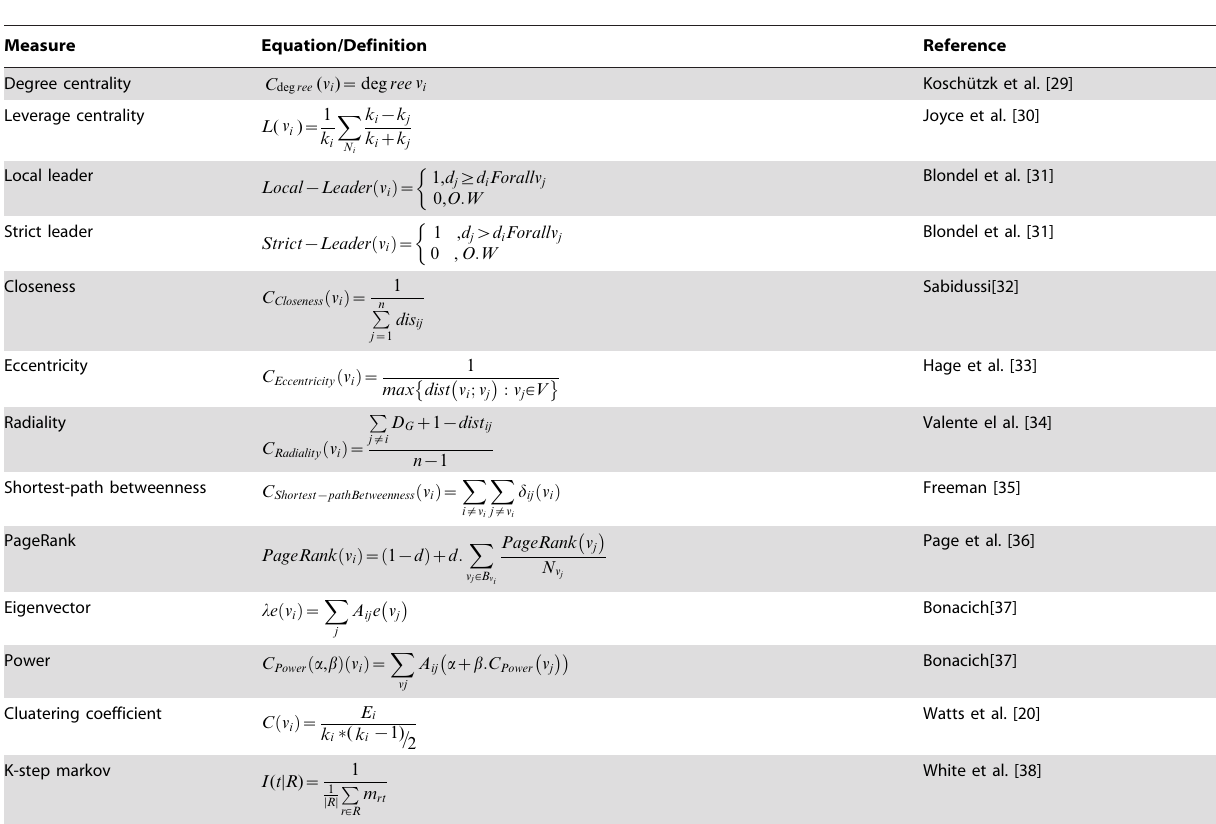
Table 1. The Centrality Measures that used to find Creative